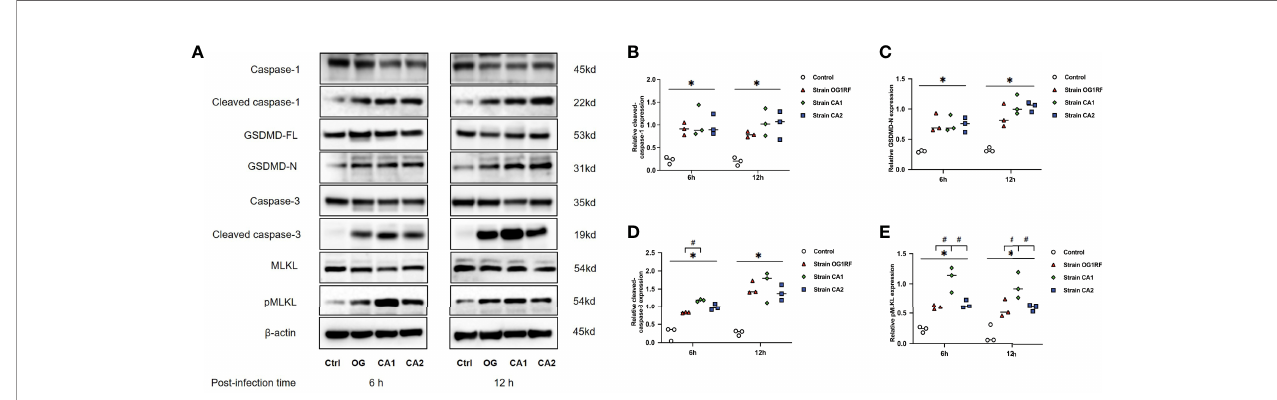
FIGURE 4 | Western blots showing the relative expression of PANoptosis-related proteins in RAW264.7 cells 6 and 12 h after E. faecalis infection. (A) Representative immunoblotting bands of eight proteins. Quanti fi cation of cleaved caspase-1 (B) , cleaved caspase-3 (C) , GSDMD-N (D) , and pMLKL (E) . Relative protein levels were quanti fi ed by analyzing the scanned protein bands using the ImageJ software after normalization to b -actin levels on the same blots. All experiments were repeated three times. * P < 0.05 compared to the control group. # P < 0.05 compared to the other experimental groups.